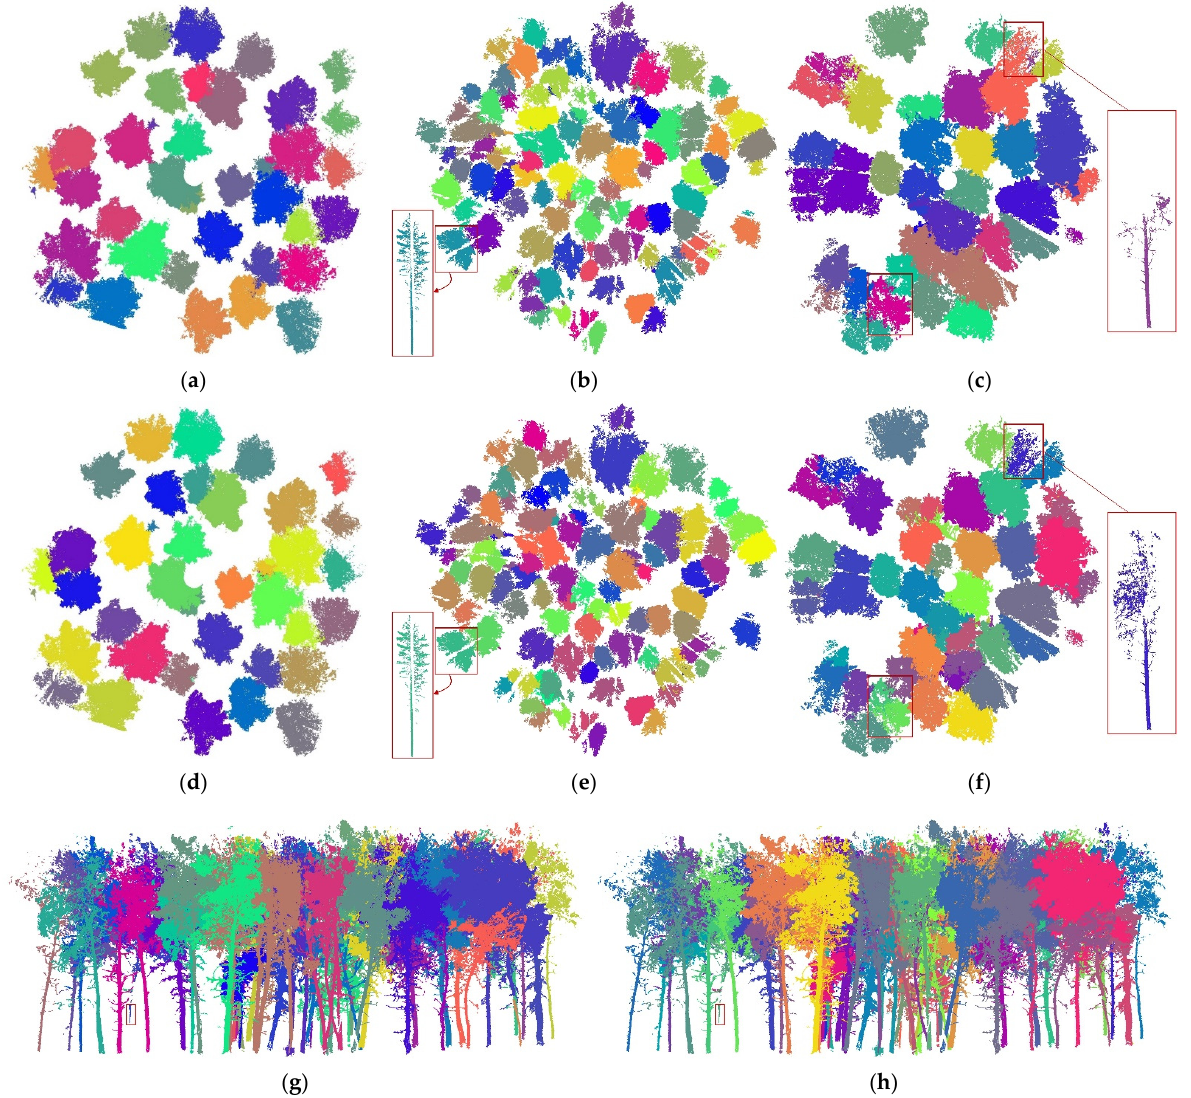
Figure 7. Example plot tree isolation from treeiso compared with reference: Spine#1 treeiso ( a ) and reference ( d ), LPine#1 treeiso ( b ) and reference ( e ), TAspen#1 treeiso ( c ) and reference ( f ) from top